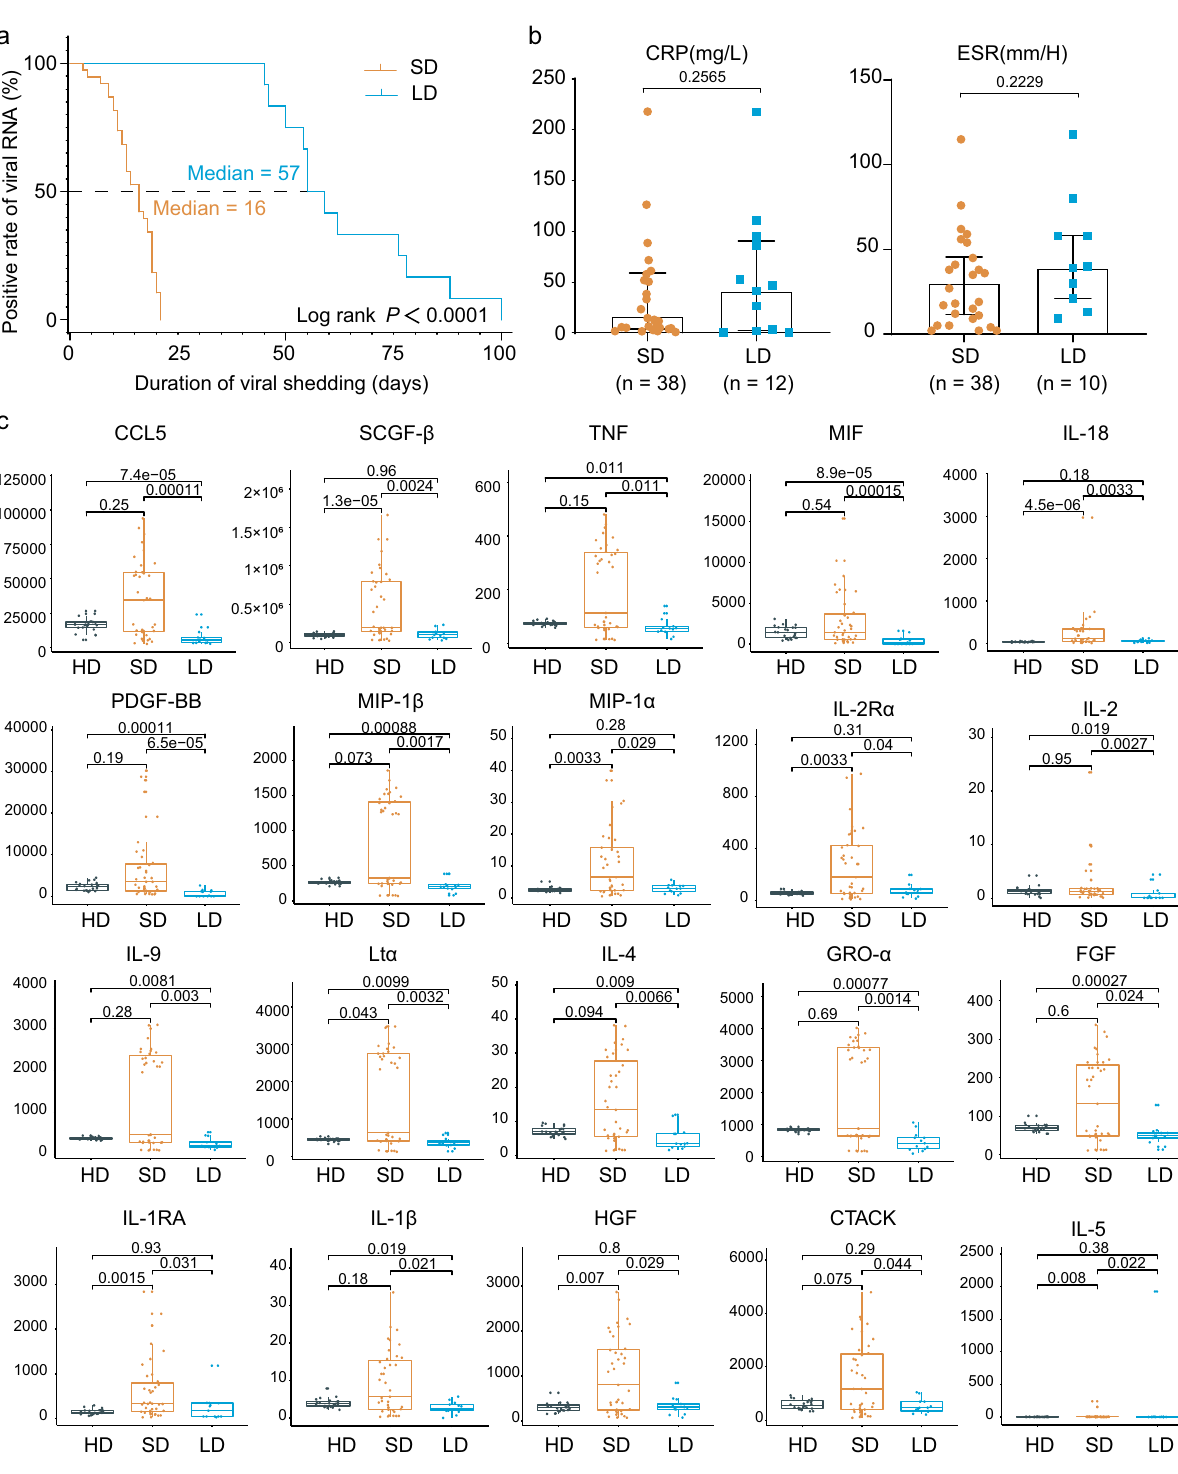
Fig. 1 Virological, clinical and cytokines/chemokines characteristics in LDs and SDs. a The Kaplan – Meier method was used to estimate the positive rate of viral RNA, and the two-sided log-rank test was applied to evaluate the signi fi cance difference of the duration of viral shedding in the LDs ( n = 12) and SDs ( n = 38). b The C-reactive protein (CRP) values obtained from clinical records of LDs ( n = 12) and SDs ( n = 38) and erythrocyte sedimentation rate (ESR) values obtained from clinical records of LDs ( n = 10) and SDs ( n = 38). The box plots show the median (middle line) and the fi rst and third quartiles (boxes), whereas the whiskers show 1.5× the interquartile range (IQR) above and below the box. Non-paired two-tailed student t test was performed. c Samples from HDs ( n = 22), LDs ( n = 12) and SDs ( n = 38) were collected, and assays were performed to measure the concentrations of 48 cytokines/ chemokines, of which 20 with statistically signi fi cant are shown. Y axis represents the cytokine concentration (pg/ml). The box plots show the median (middle line) and the fi rst and third quartiles (boxes), whereas the whiskers show 1.5× the IQR above and below the box. One-sided Wilcoxon rank-sum test are performed. Source data are provided as a Source Data fi